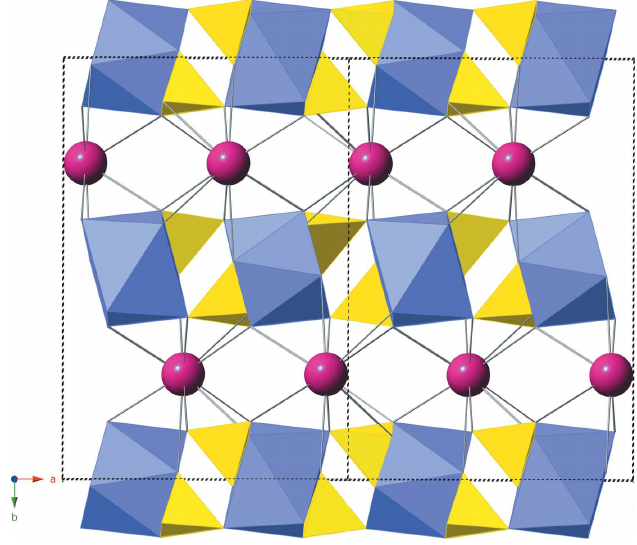
Figure 1 Displacement elliposid (90% probability level) representation of two unit cells of CsNd(SO 4 ) 2 : O atoms are red, S atoms yellow, Cs magenta and Nd pale-lavender.